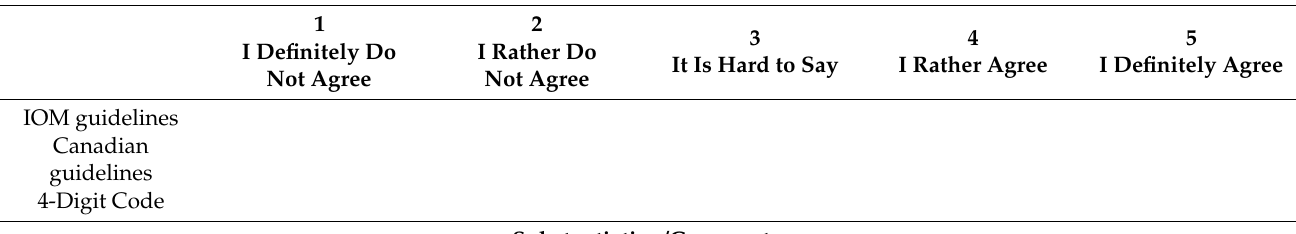
Table 1. A sample question and answer